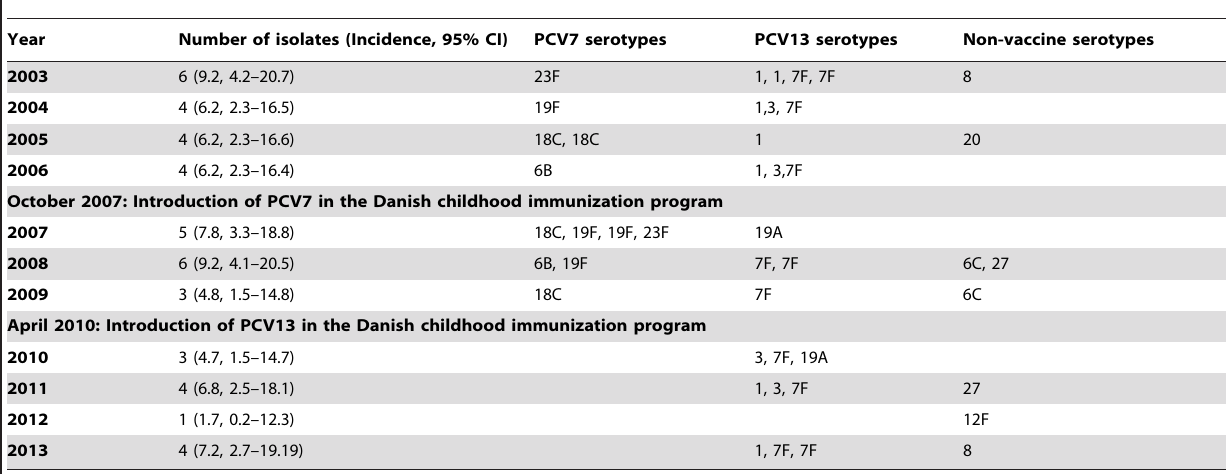
Table 1. Pneumococcal serotypes from infants younger than 90 days with invasive pneumococcal disease from 2003 through